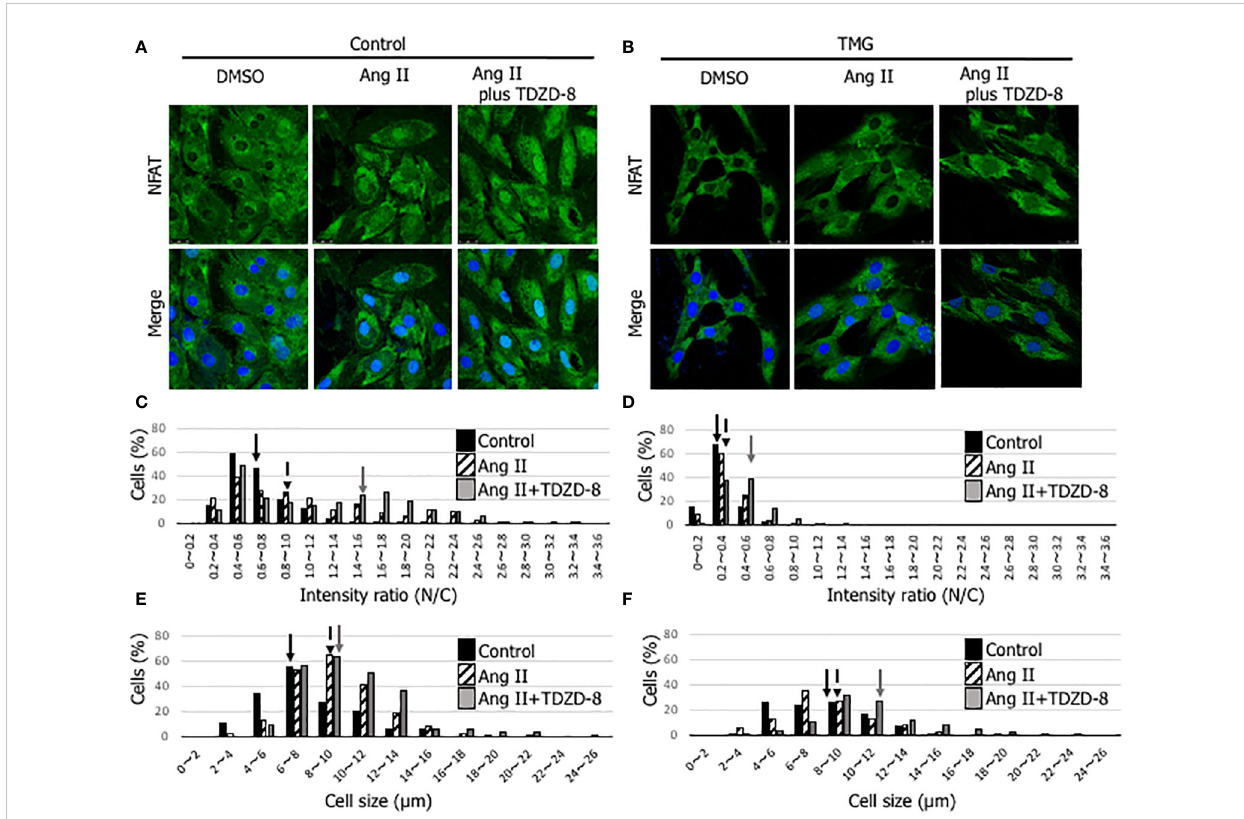
FIGURE 7 Inactivation of the NFAT signaling pathway with TMG treatment and the restoration by the treatment of TDZD-8 in Ang II-stimulated H9c2 cells. (A, B) NFAT (green) and DAPI (blue) staining was performed to examine the effect of DMSO- (A) or TMG- (5 m M) (B) treatment with or without the pretreatment of TDZD-8 (2 m M) on angiotensin II (1 m M)-stimulated H9c2 cells. Representative data was designated. The cells were fi xed with 4% PFA, and observed with confocal microscopy. Scale bar: 25 µm. (C, D) The nuclear/cytosol (N/C) ratio was calculated by ImageJ software to examine the effect of DMSO- (C) or TMG- (D) treatment with or without the pretreatment of TDZD-8 in Ang II-stimulated H9c2 cells, and designated in histogram. (E, F) The cell size was measured to examine the effect of DMSO- (E) or TMG- (F) treatment with or without the pretreatment of TDZD-8 in Ang II-stimulated H9c2 cells, and designated in histogram. Closed bar, Control cells; Hatched bar, Ang II-stimulated cells; Shaded bar, Ang II-stimulated cells with the pretreatment of TDZD-8. Arrows indicate median values of the distributions. TMG,Thiamet G; DMSO, Solvent